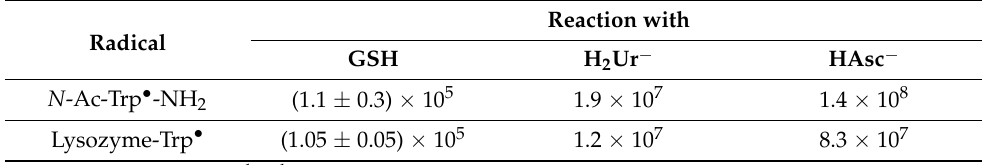
Table 1. Rate constants of reactions of the endogenous antioxidants with Trp radicals. Radical